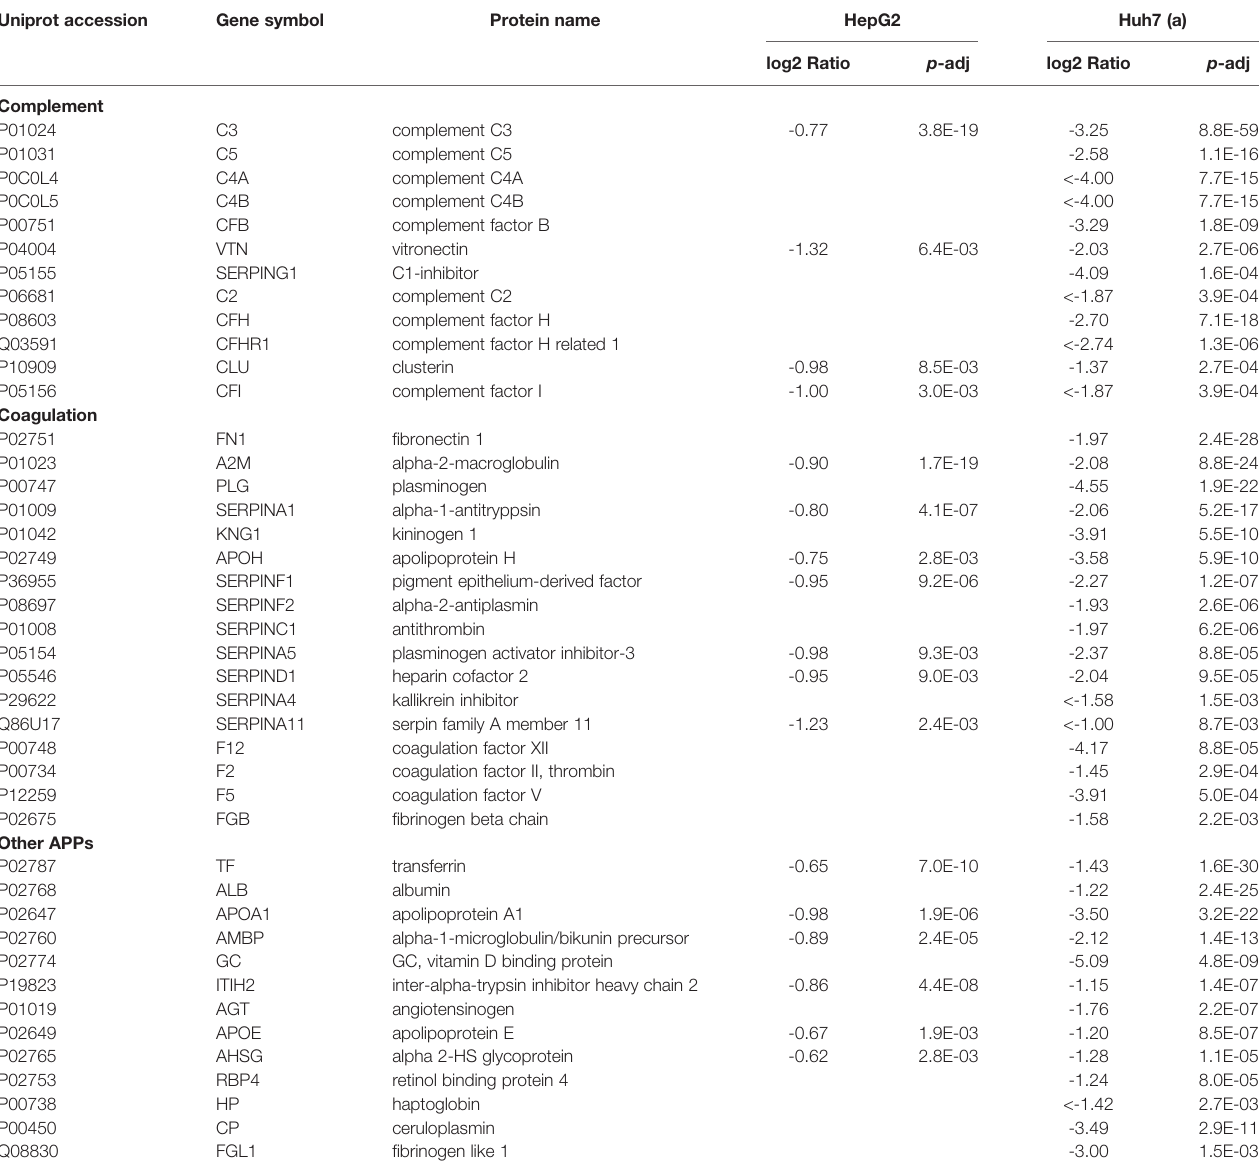
TABLE 2 | Long-term Listeria infection decreases the abundance of APP in the secretome of HepG2 and Huh7 hepatocytes. Uniprot